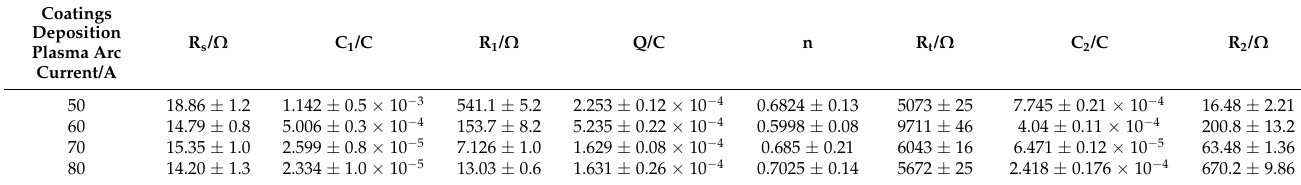
Figure 12. Electrochemical impedance spectroscopy in the middle of the CoCrFeNiMn HEA coatings ( a ). and the equivalent fitting circuit ( b ). Table 8. Equivalent circuit parameters of the CoCrFeNiMn HEA coatings.